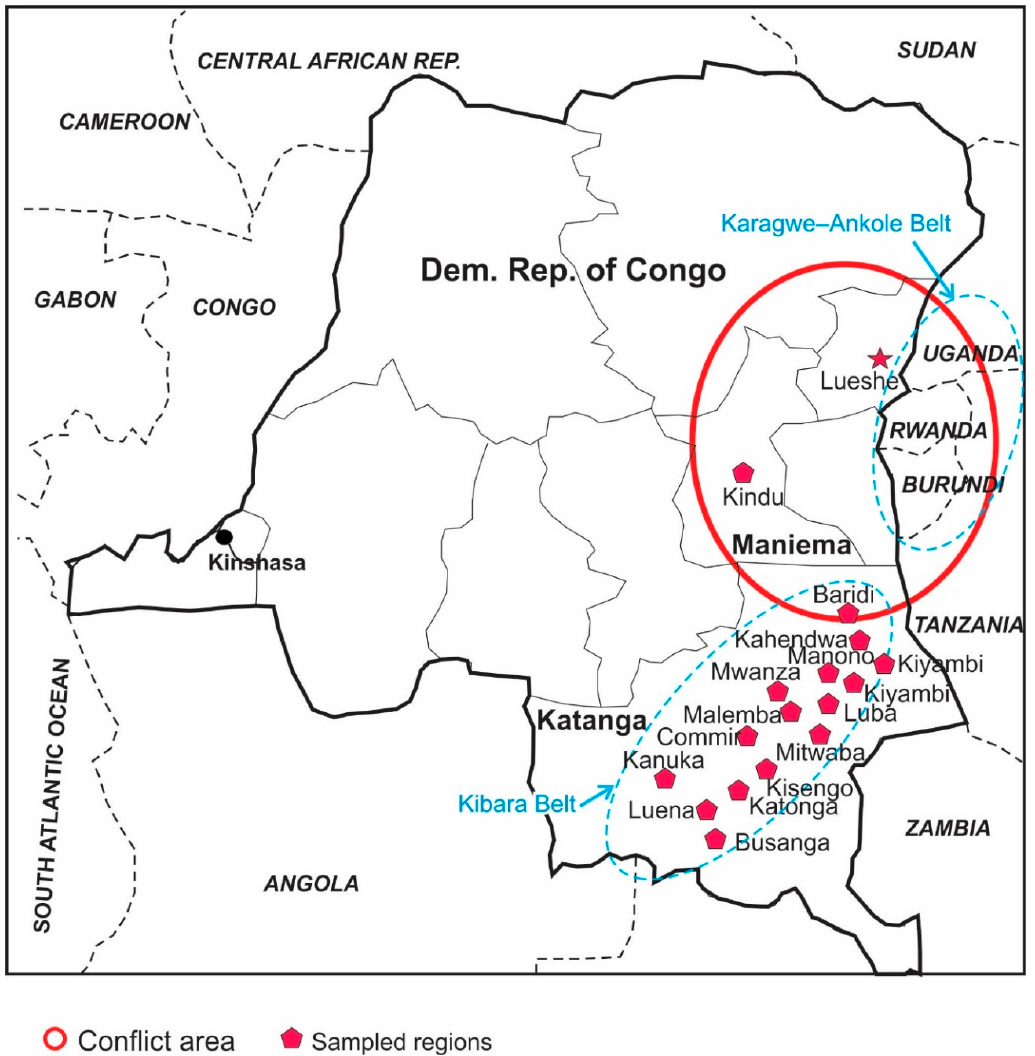
Figure 2. Location of regions in two provinces (Maniema, Katanga) that were sampled for this study. Lueshe Nb deposit in NE side, as well as Kibara and Karagwe-Ankole metalogenic belts (oval dash lines), are also shown.